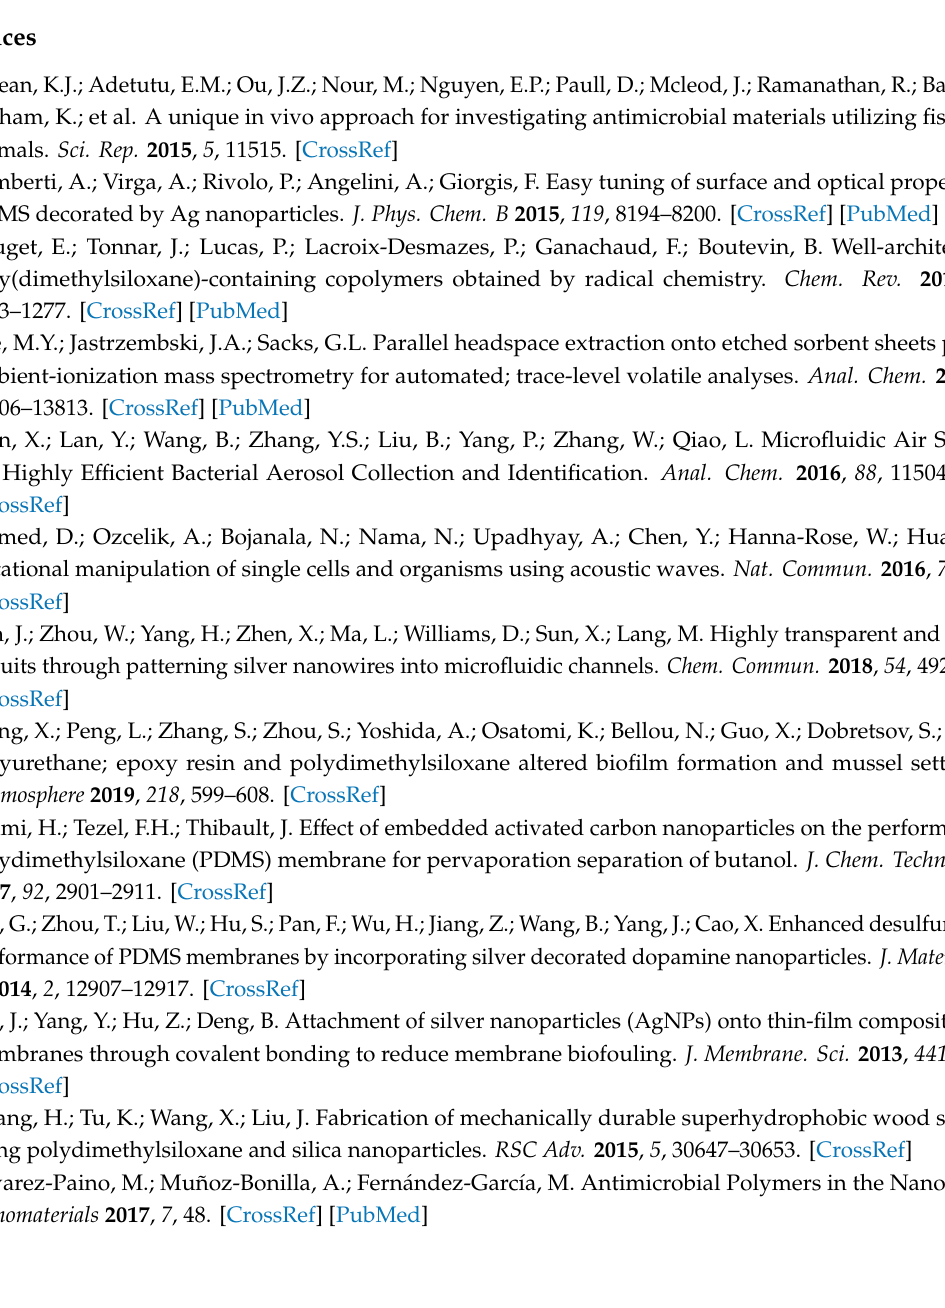
their surface. Figure S2: Growth of E. coli on the surface of PDMS, PDMS-SMs, PDMS-SMs-AgNPs (sparse / tight). Figure S3: ZOI assay of PDMS and PDMS-SMs-AgNPs with Bacillus subtilis after 24 h incubation at 37 ◦ C. Figure S4: Growth of Bacillus subtilis on the surface of PDMS, PDMS-SMs, PDMS-SMs-AgNPs. Figure S5: Cell numbers of Bacillus subtilis growing on the PDMS, PDMS-SMs, sparse / tight SMs-AgNPs modified PDMS. Author Contributions: Experimentation design, Q.S.; sample synthesis and characterization, Q.S., Y.S. and